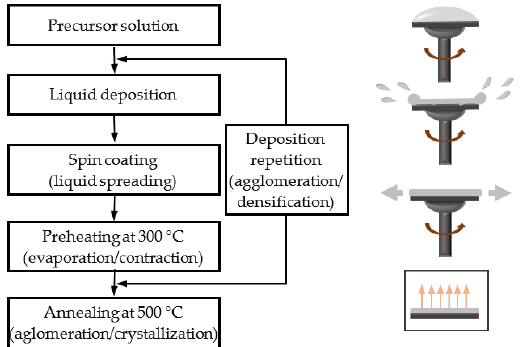
Figure 1. Deposition principle of sol-gel spin-coated ZnO samples and illustration of the liquid spreading, and film formation steps.